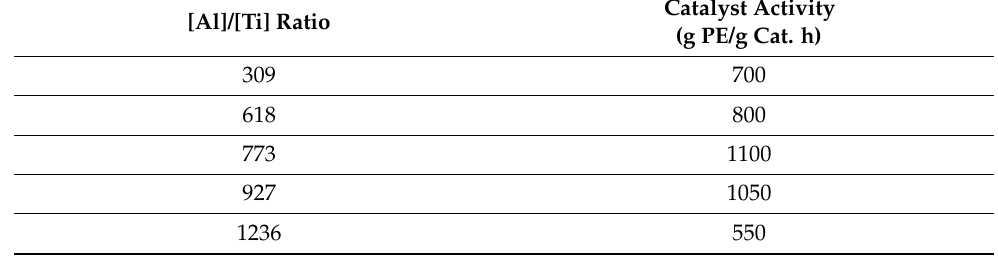
Table 1. Influence of [Al]/[Ti] molar ratios on catalyst activity in ethylene polymerization. [Al]/[Ti] Ratio